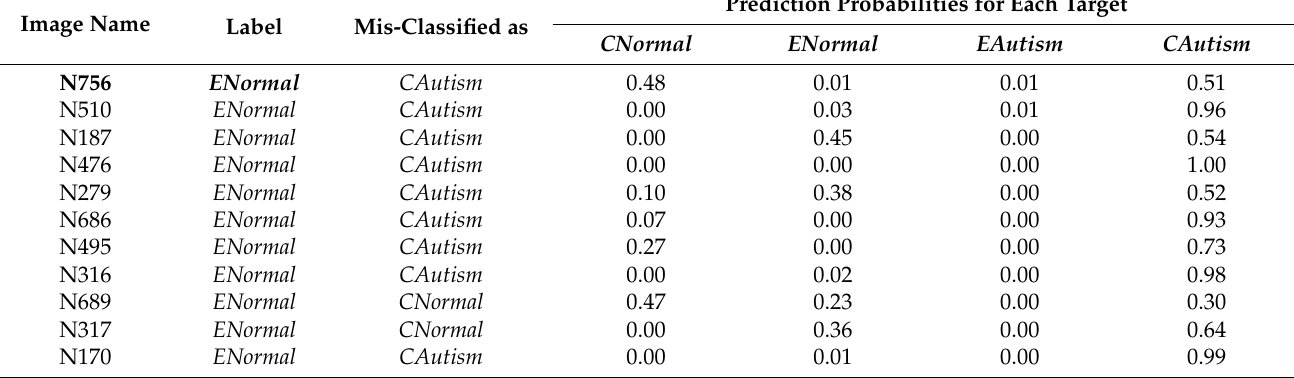
Table A4. Probability distribution for the 4 targeted classes for the 11 cases in Table A3 where ENormal was misclassified as CAutism (9) and CNormal